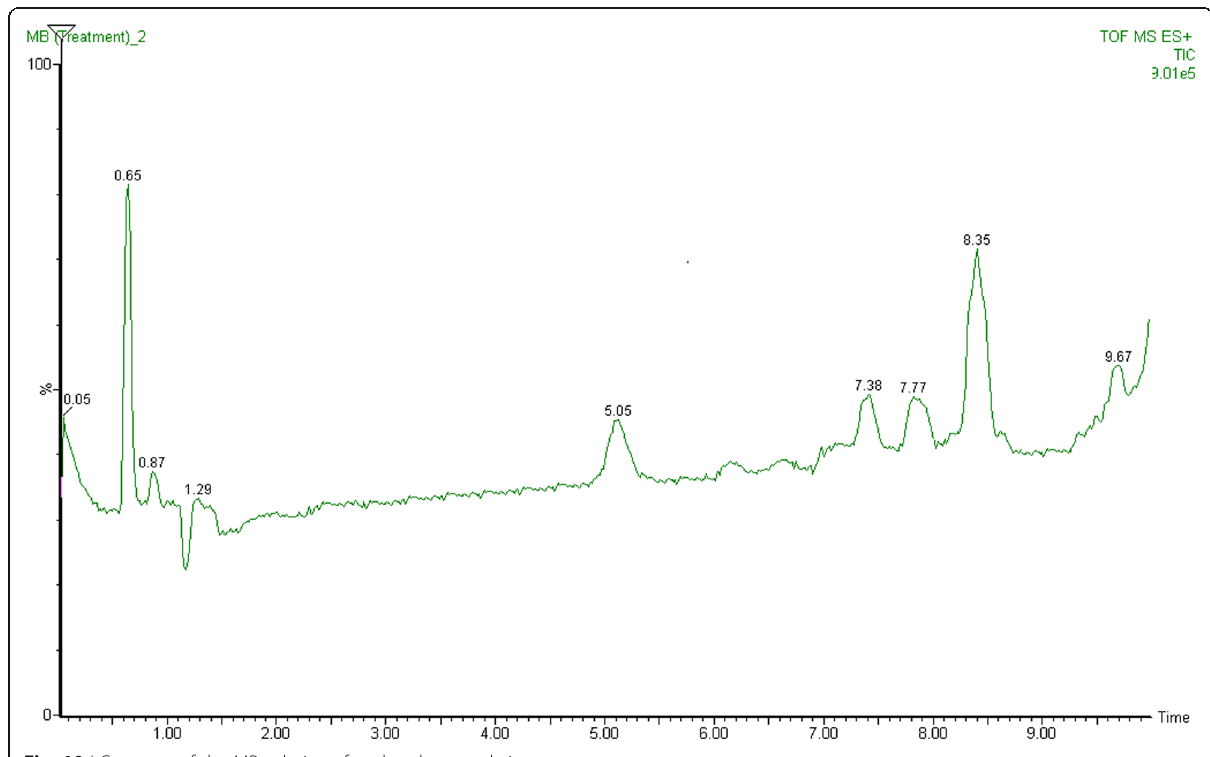
Fig. 10 LC spectra of the MB solution after the photocatalytic